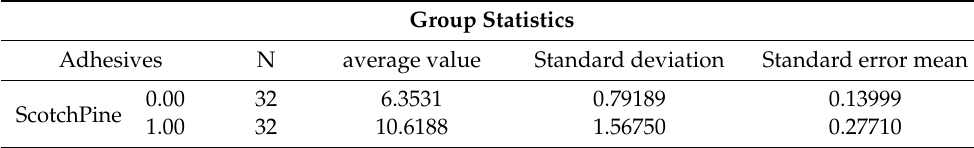
Table 1. Scotch pine’s t -test analysis for adhesives. (Group Statistics).